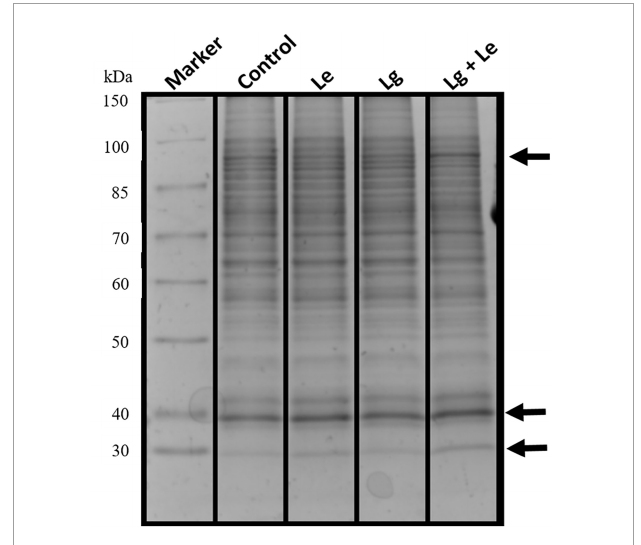
FIGURE2 Protein extracts obtained from mycelia of B. cinerea exposed to different essential oils treatment fractionated on a 12% denaturing 1D SDS polyacrylamide gel showing separated proteins with no protein